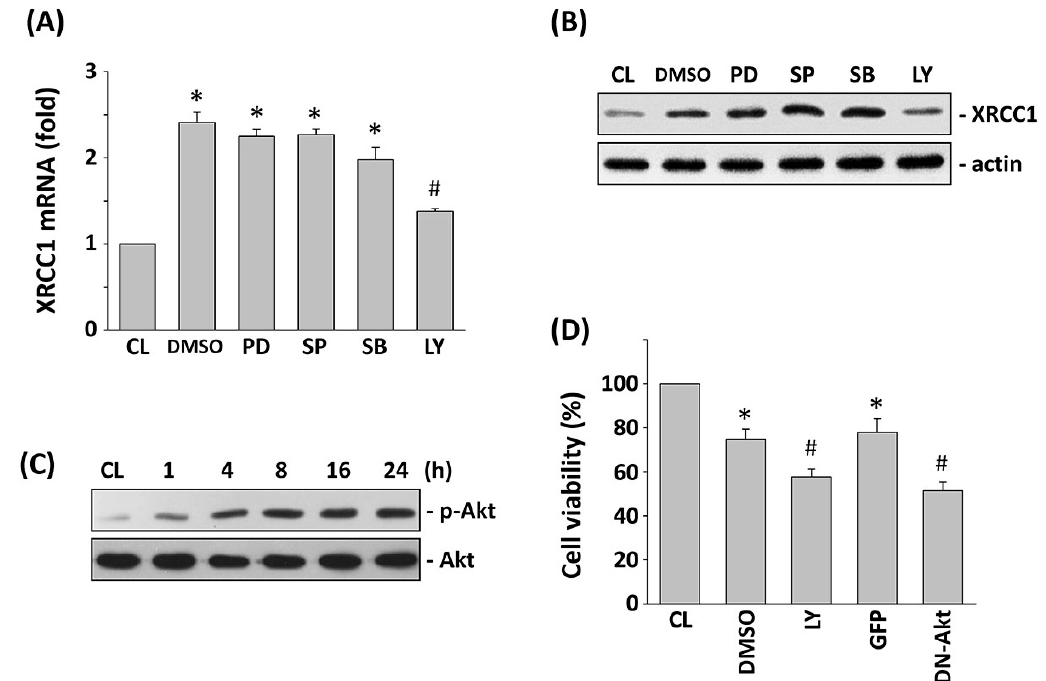
Figure 3. Stimulation with 5-FU regulated XRCC1 expression through Akt activation. HCT-116 cells were pretreated with mitogen-activating protein kinases (MAPK) inhibitor or PI3K/Akt inhibitor individually for 1 h, or infected with vectors expressing the green fluorescent protein (GFP) or dominant-negative (DN)-Akt, and then treated with 5-FU for 24 h ( A , B , D ) or for indicated time periods ( C ). ( A ) Expression of the XRCC1 mRNA was determined by real-time PCR analysis and normalized to 18S rRNA. ( B , C ) The expression of XRCC1 ( B ) and phosphorylation of Akt ( C ) was determined by Western blotting. ( D ) Cell viability was assayed using the MTT test. The results are shown as mean ± SEM. * p < 0.05 versus CL. # p < 0.05 versus dimethylsulfoxide (DMSO)- or GFP-treated cells with 5-FU treatment.